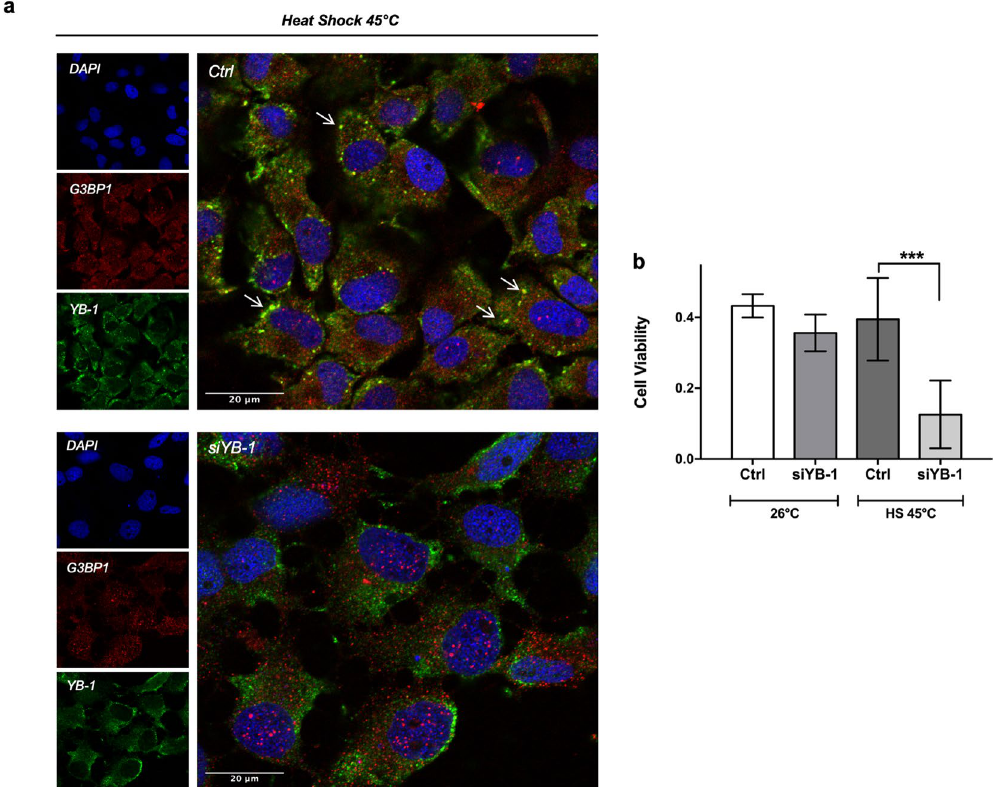
Figure 6. YB-1 is essential for SG formation and PAC2 cell viability upon thermal stress. ( a ) Confocal immunofluorescence analysis of G3BP1 (red) and YB-1 (green) in control (upper panel) and YB-1-silenced PAC2 cells (lower panel) after heat shock treatment (45 minutes at 45 °C). Nuclei were stained with DAPI (blue) and both single and merged images are presented. White arrows indicate SGs; ( b) cell viability assay (MTT) in control or YB-1-silenced PAC2 cells at 26 °C or after heat shock (45 minutes at 45 °C). Statistical analysis was performed using 1-way ANOVA followed by Tukey’s multiple comparisons test. Levels of significance are indicated ( *** p 0.001) (see also Table